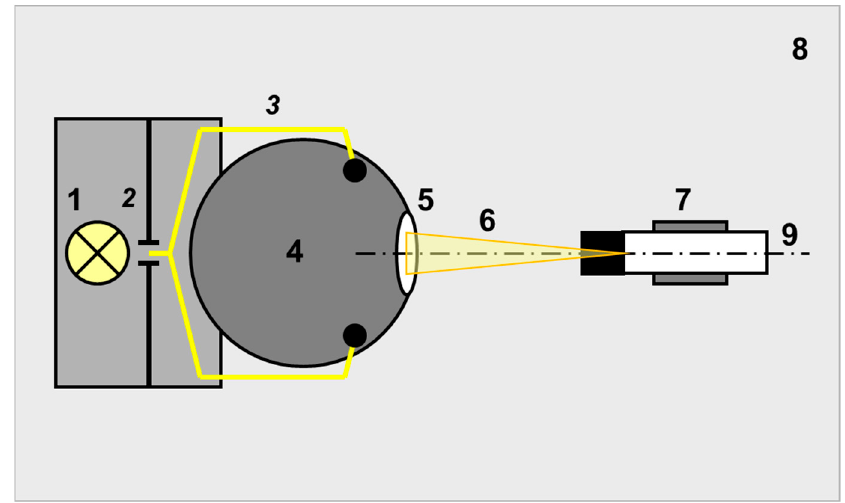
Figure 4. Indoor radiance comparison. 1—quartz tungsten halogen lamp; 2—variable slit; 3—optical fiber; 4—integrating sphere; 5—output port; 6—FOV of the radiometer; 7—radiometer on the support; 8—optical table; 9—main optical axis .